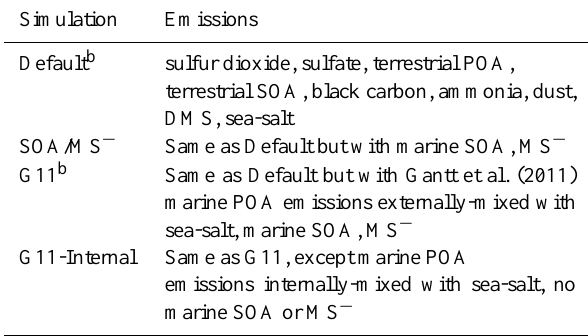
Table 1a. Description of the CAM5 simulations a in the Part 1 paper that are further analyzed here in this work (i.e., the Part 2